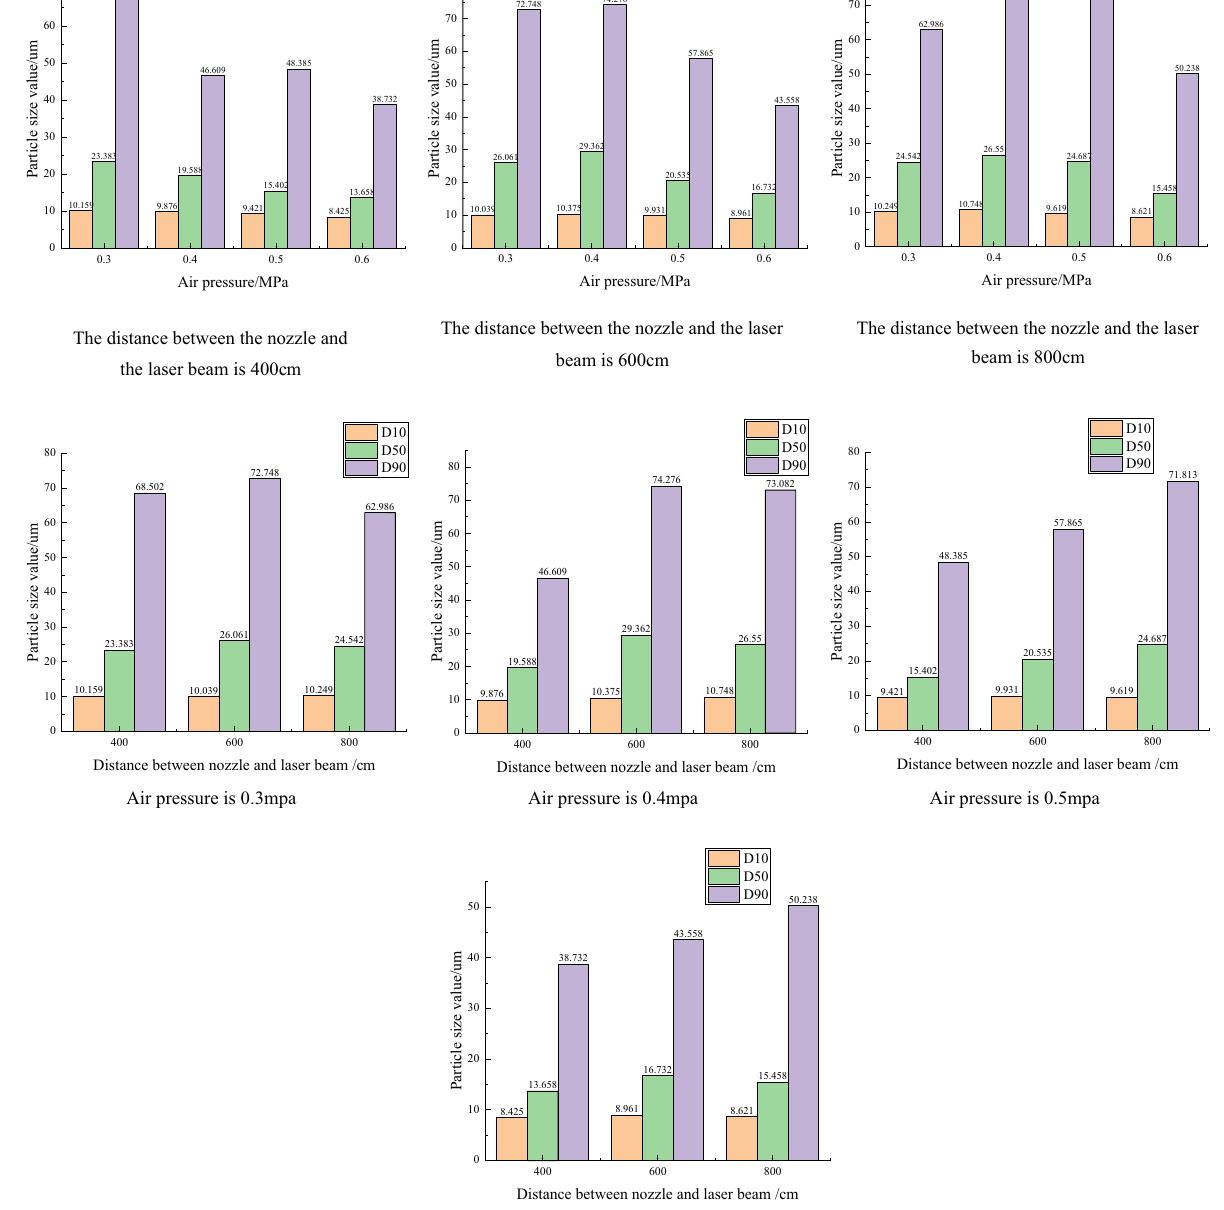
Figure 9. 30 Particle size values under different air pressures and